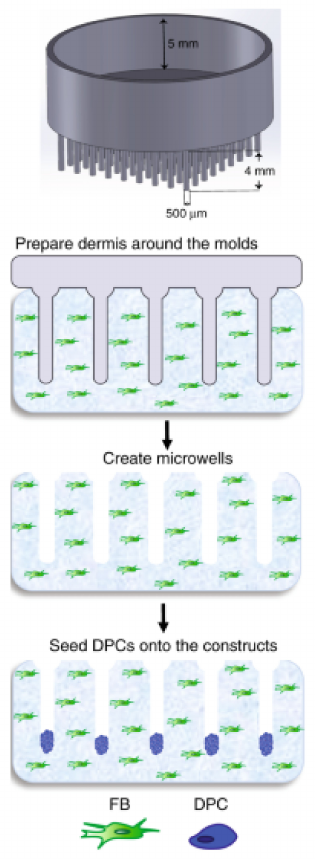
Figure 7. Schematic showing 3D-printed mold used for construction of a vascularized, hair follicle- containing 3D HSE. Adapted from [106], published by Nature Portfolio,